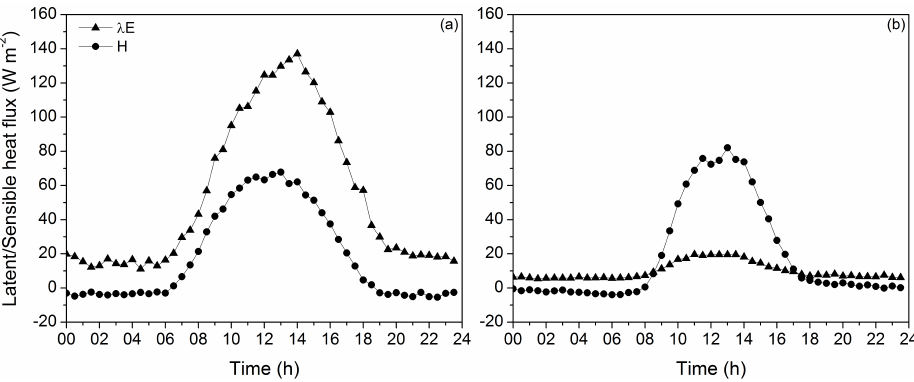
Fig. 6. Average diurnal pattern of latent heat flux ( λE) and sensible heat flux ( H ) in summer (JJA, a ) and winter (DJF, b